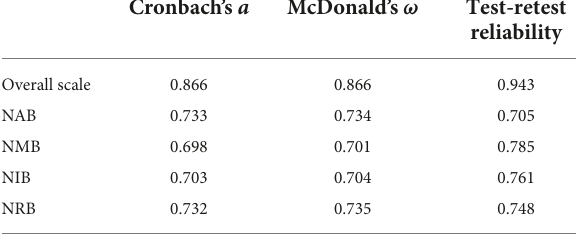
TABLE 7 Cronbach’s α , McDonald’s ω , and test-retest reliability of the negative cognitive processing bias